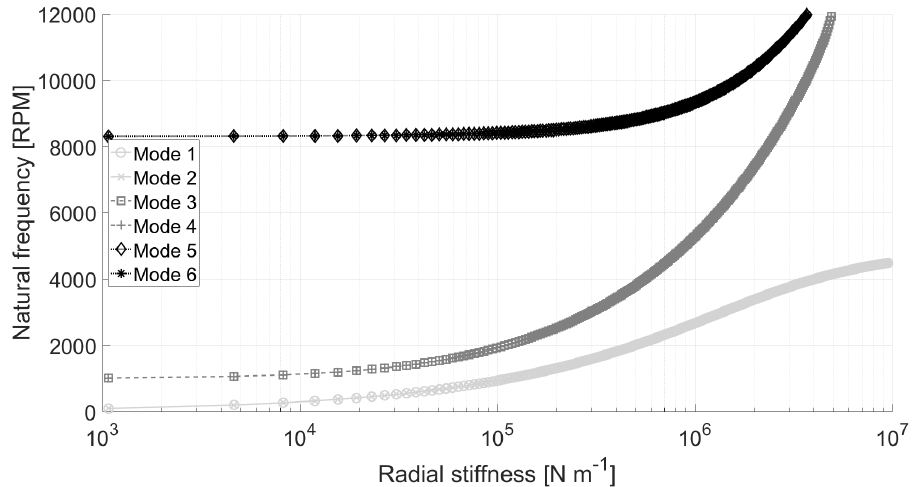
Figure 6. Active Magnetic Bearing stiffness influence on natural frequencies at 0 RPM.